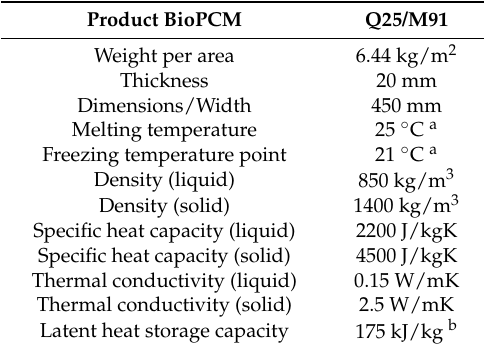
Table 3. Physical properties of PCM, which is used in simulations